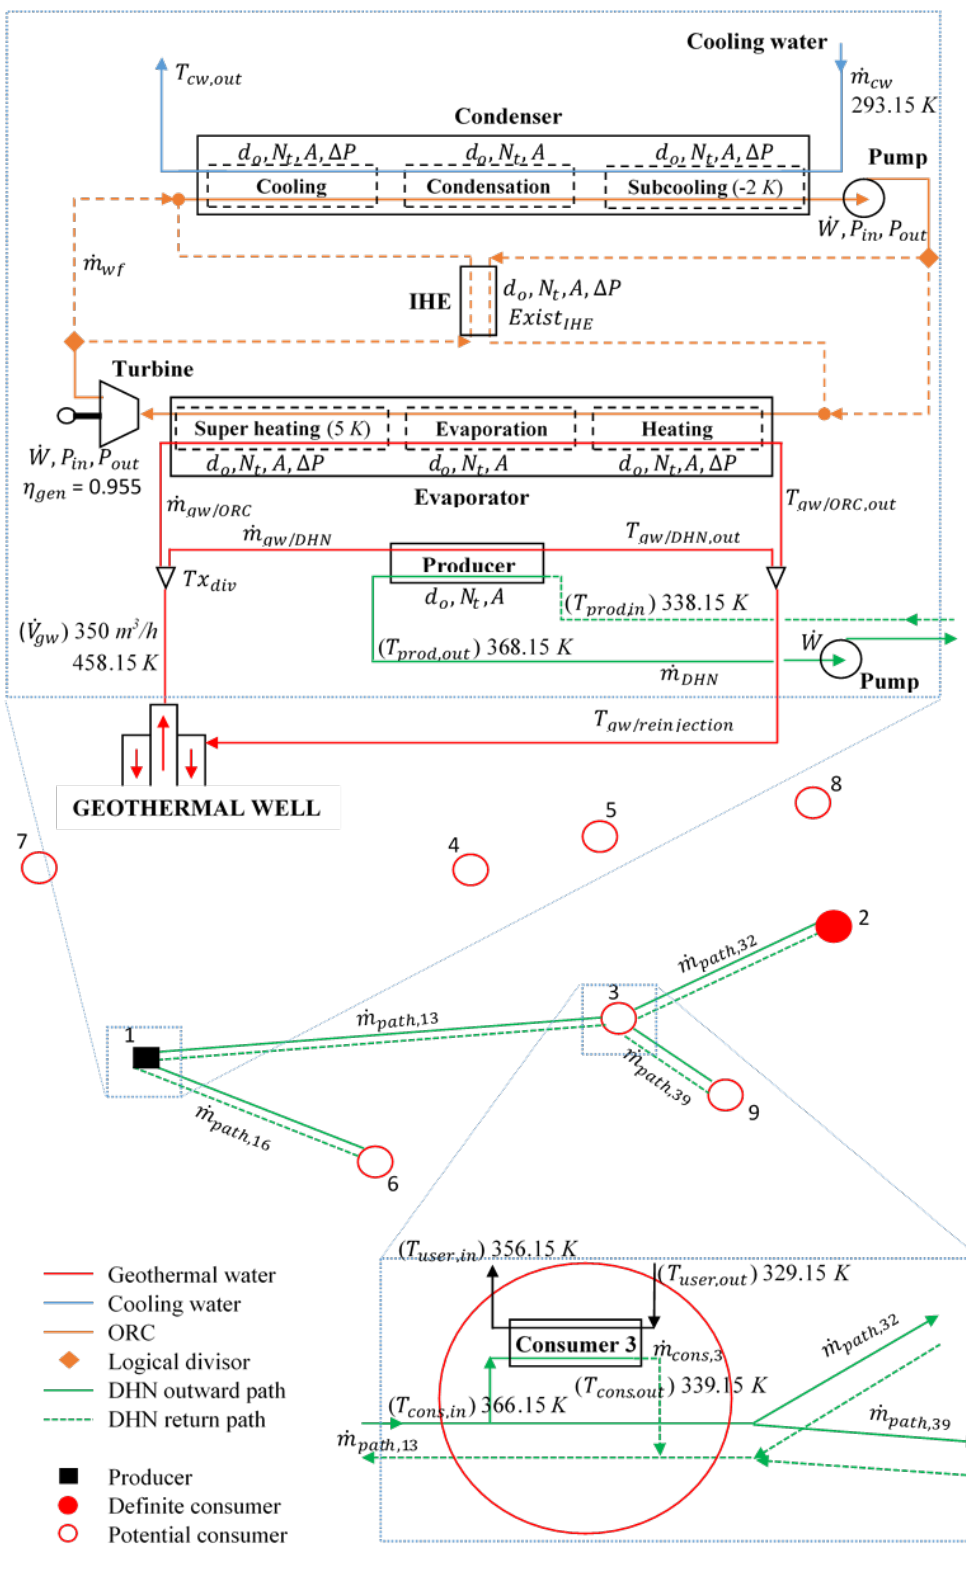
Figure 2. Superstructure of the optimization problem and main variables and input data. Table 1. Heat required (MW) for each consumer.